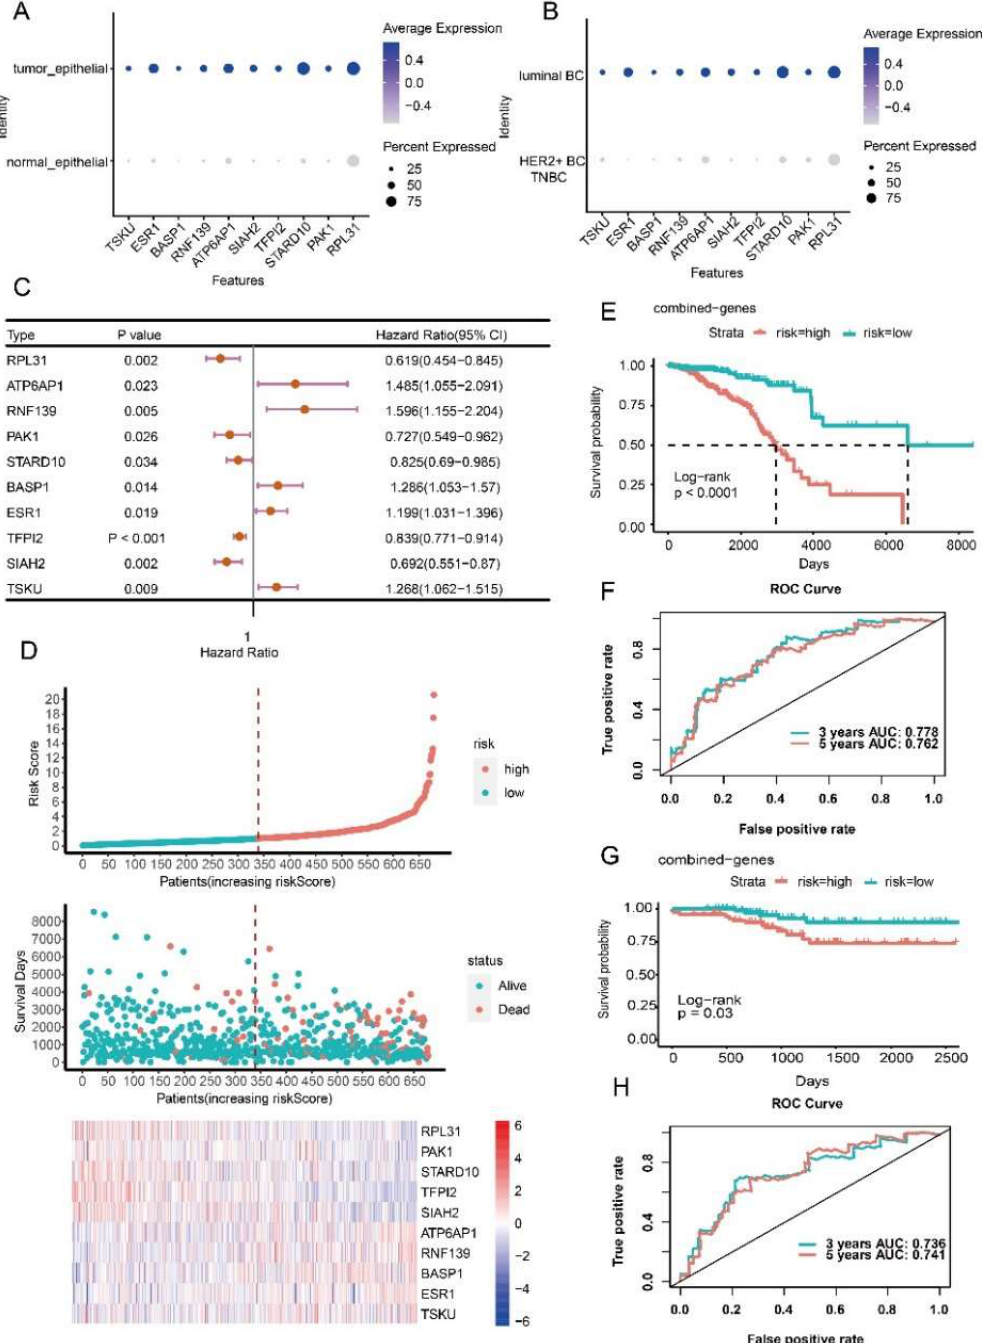
Figure 5. Construction and evaluation of the prognostic risk model for luminal BC. ( A ) Expression levels of prognostic factors between normal and cancer cells. ( B ) Expression levels of prognostic factors in cancer cells of luminal BC and other subtypes. ( C ) HR and p values of prognostic factors by univariate Cox regression. ( D ) Risk curves and scatter plots of sample survival probability for each sample reordered by risk score, heatmap of expression of prognostic factors in low-risk and high-risk groups. ( E ) Differences in overall survival between high-risk and low-risk groups in the training cohort of luminal BC. ( F ) Receiver operating characteristic curve (ROC) analysis of the sensitivity and specificity of the prognostic model in the training cohort of luminal BC. ( G ) Differences in overall survival between high-risk and low-risk groups in the external validation cohort of luminal BC. ( H ) ROC analysis of the sensitivity and specificity of the prognostic model in the external validation cohort of luminal BC.